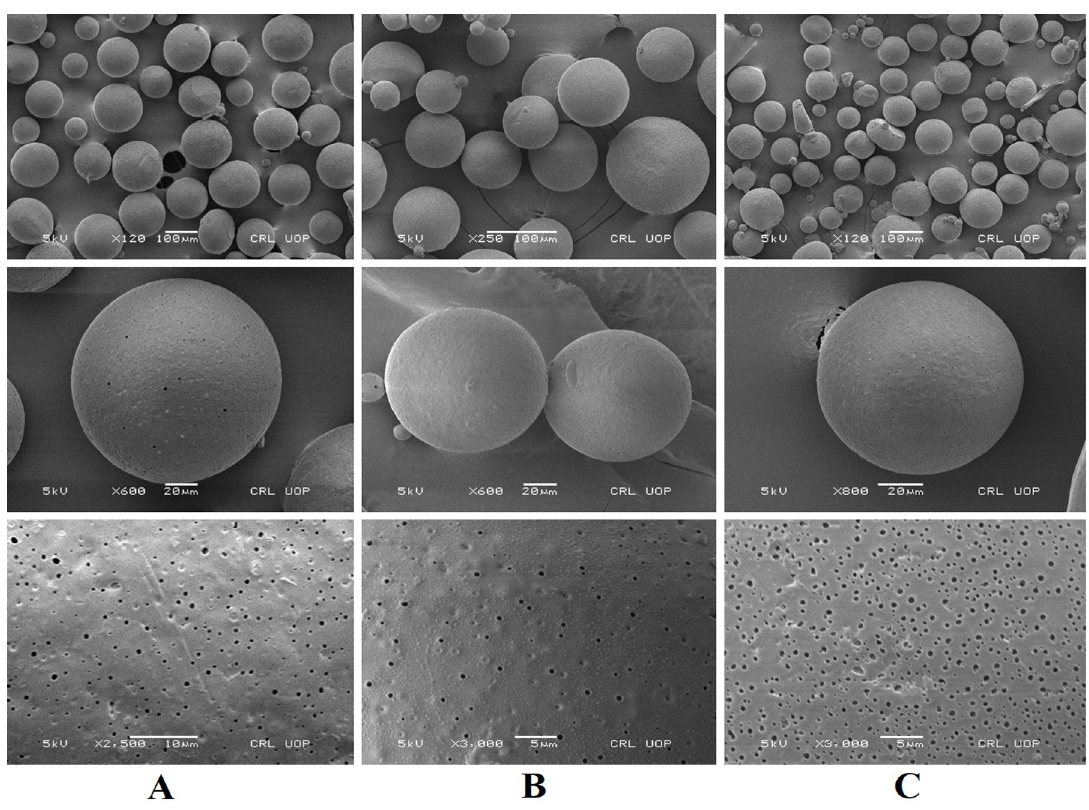
Fig 5. SEM analysis of Formulation P3 (A), Formulation P5 (B) and Formulation P10 (C) at different